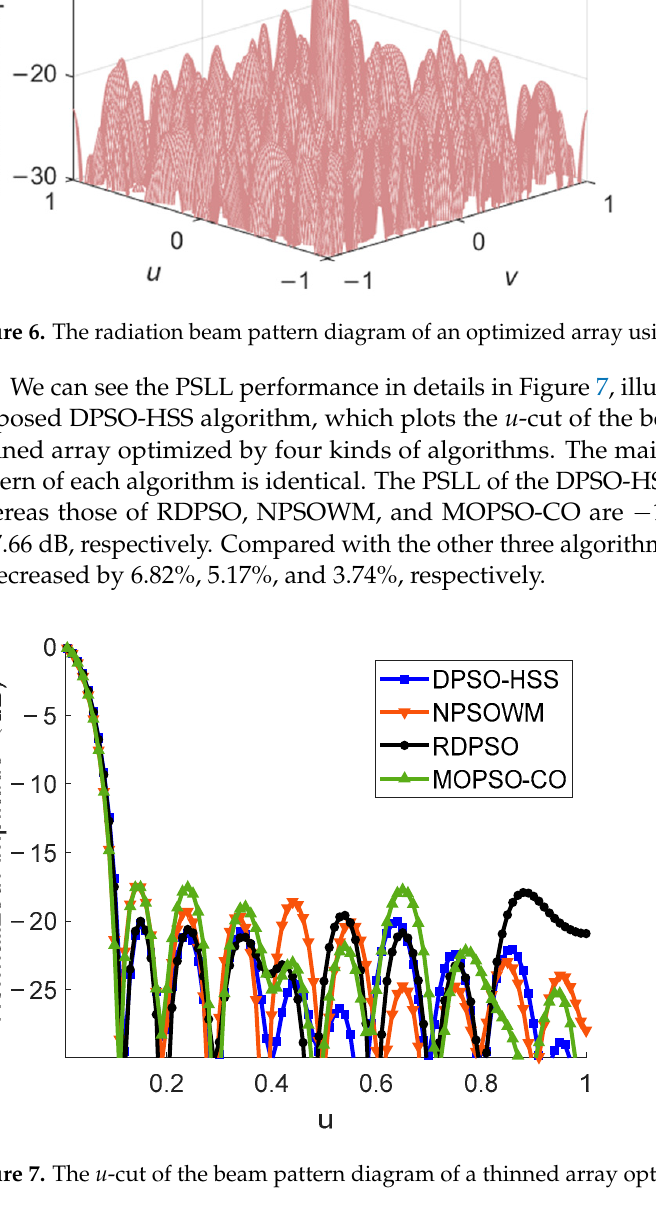
Figure 7. The u -cut of the beam pattern diagram of a thinned array optimized by each algorithm.